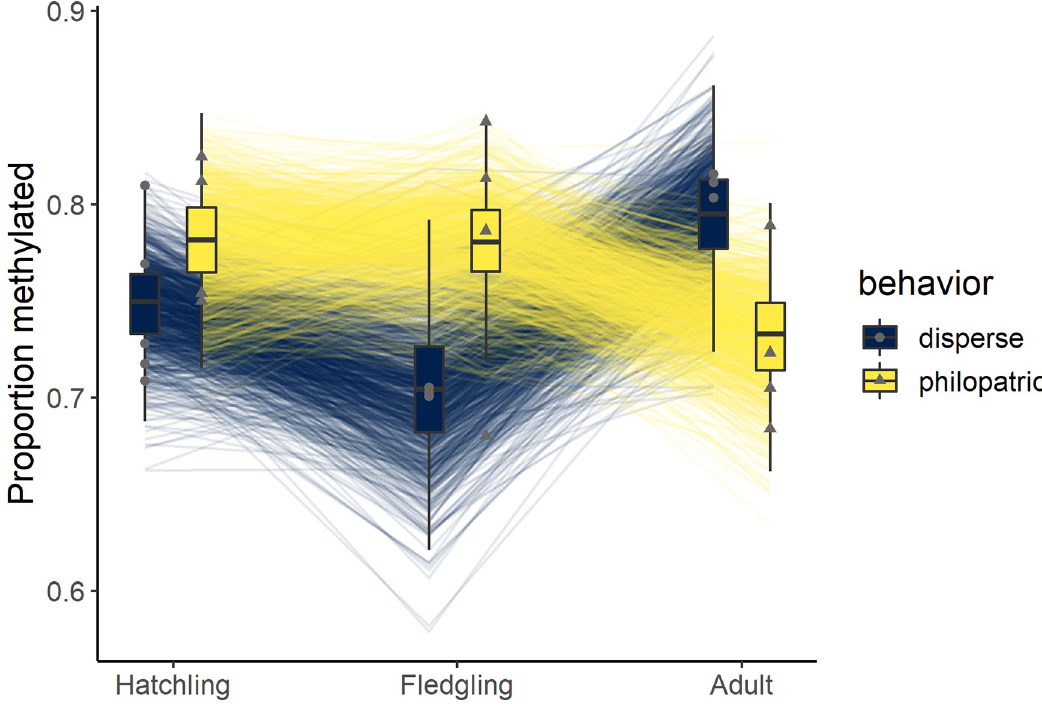
Fig 1. Mean proportion of methylated loci at hatching, fledging, and 1 year for dispersing and philopatric chestnut-crowned babblers. Boxplots represent summaries of the posterior distribution, lines connect estimated values in each stage across 1000 iterations of the posterior distribution, and data points are the raw